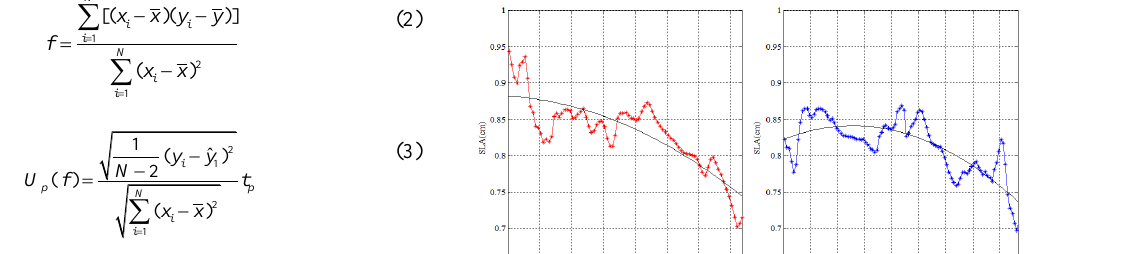
Figure 1. Spatial distribution of annual mean SLA between 1993 and 2016